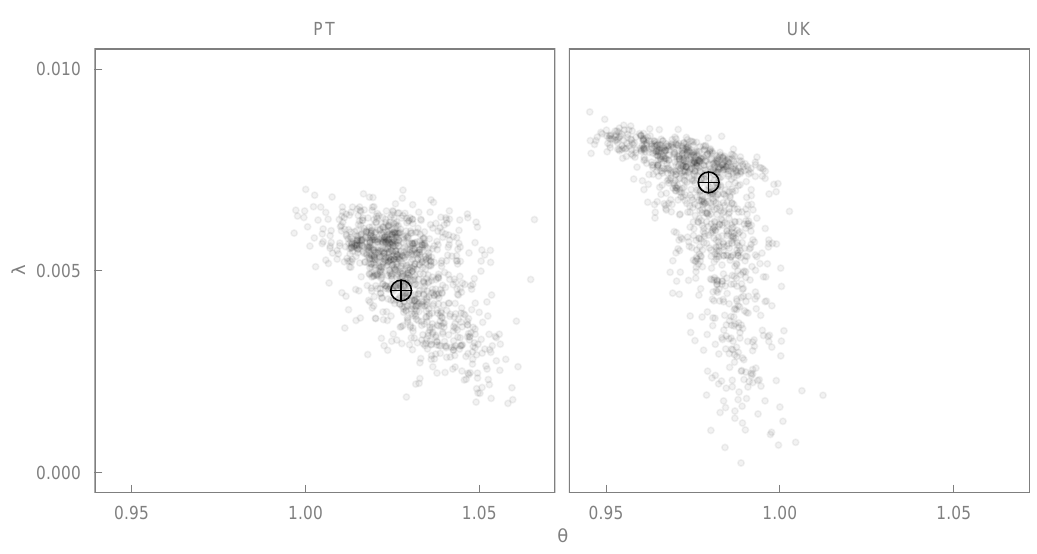
Figure 7. Bootstrap resampling distribution for ˆ λ and ˆ θ for resampled CES models that reject the CSP, include energy, use quality-adjusted factors of production, and employ the ( kl ) e nesting. Parameter estimates from the original data (ˆ λ and ˆ θ ) are shown as crosshairs ( ⊕ ). Each dot ( • ) represents parameter estimates from one of the 1000 resampled data sets. 95% transparency is used so that twenty coincident dots will appear black.